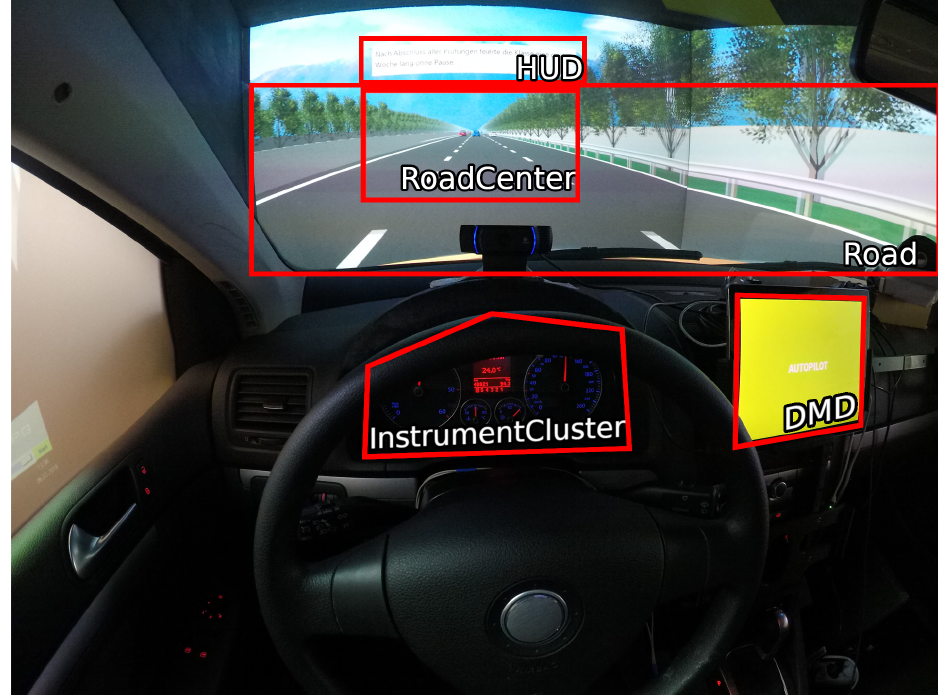
Figure 3. Analyzed areas of interest (AoIs). Also introduced was an “Other”-AoI as target of all fixations which were not within the bounding boxes of the discretely defined